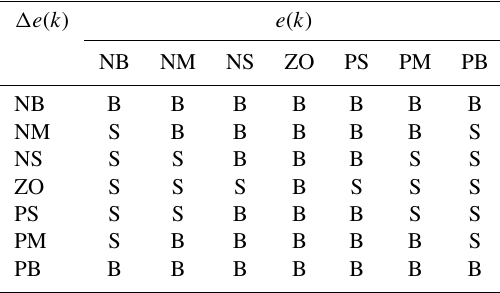
Table 1. Fuzzy Tuning Table for Kpp of PID Controller.